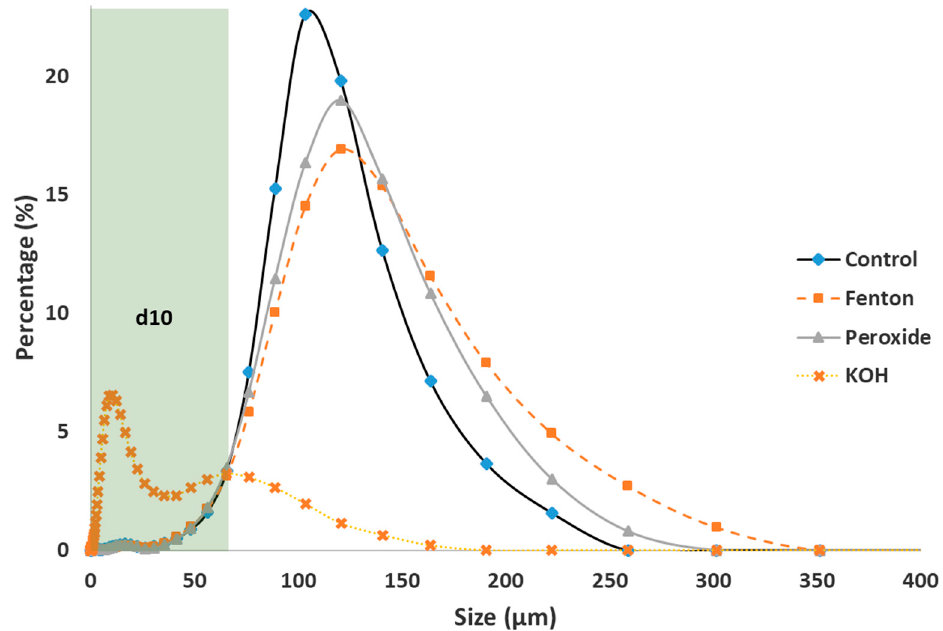
Figure 5. Size distribution analysis for PLA, the green area represents the smallest 10th percent (d10).